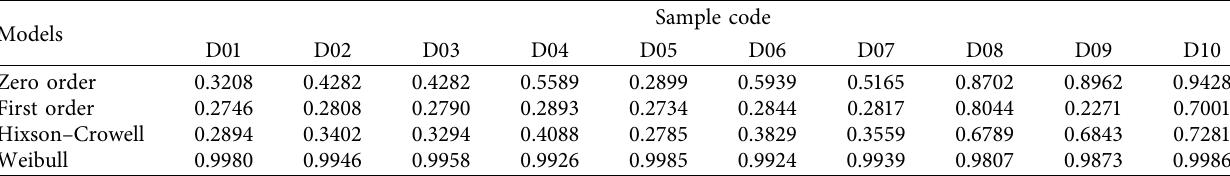
Table 4: Model-dependent approaches results of doxycycline hyclate 100mg brands when correlation coefficients were considered.